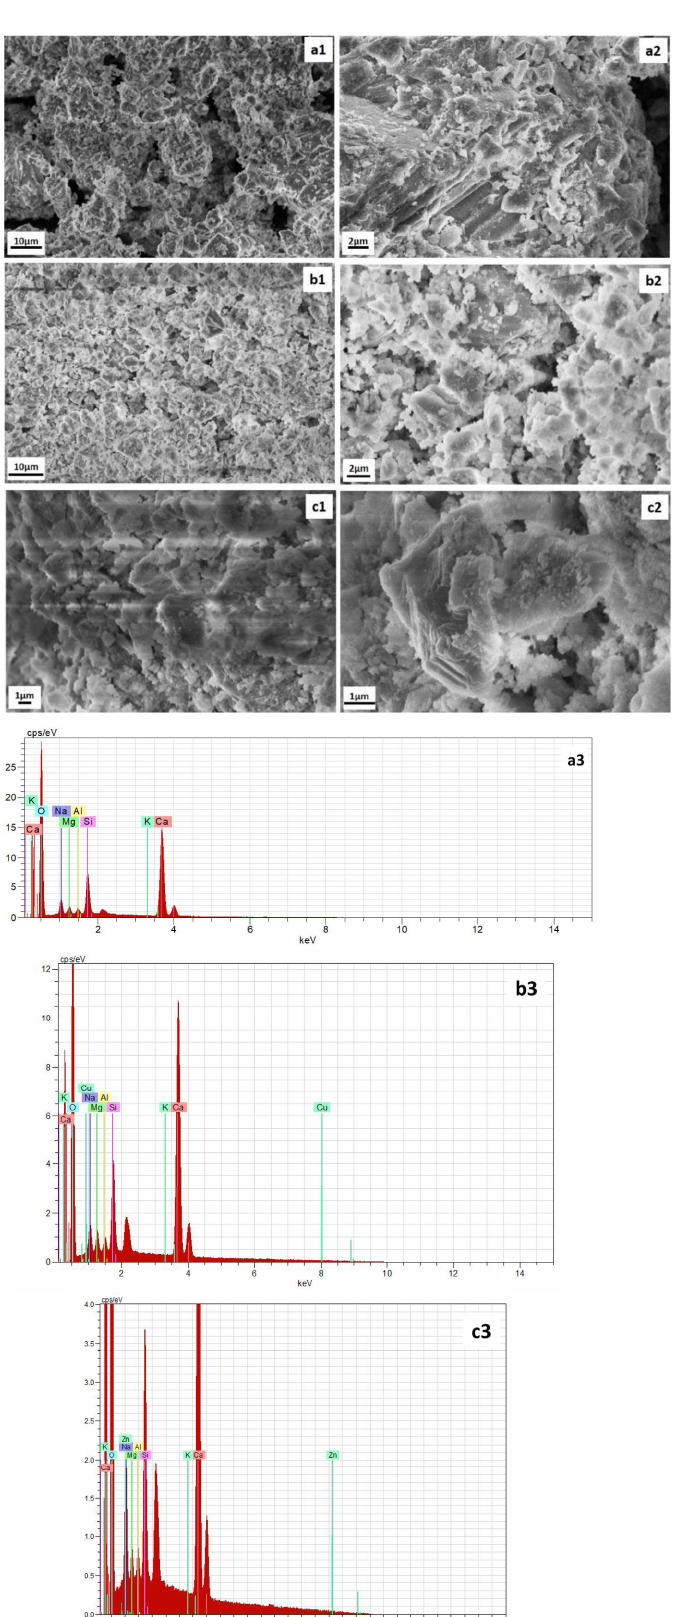
Figure 6. SEM images of ( a1 , a2 ) GWC IPs (control); ( b1 , b2 ) with 0.5% CuO NPs and, ( c1 , c2 ) with 1% ZnO NPs; and ( a3 , b3 , c3 ) EDS